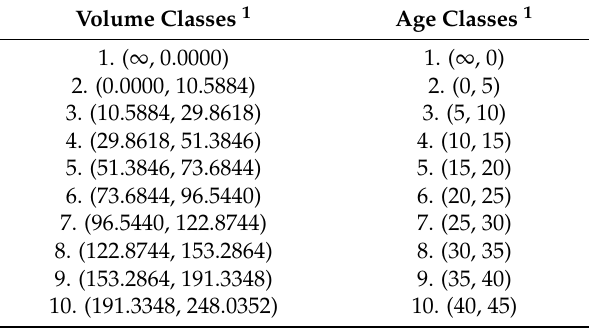
Table A1. Class limits used in all